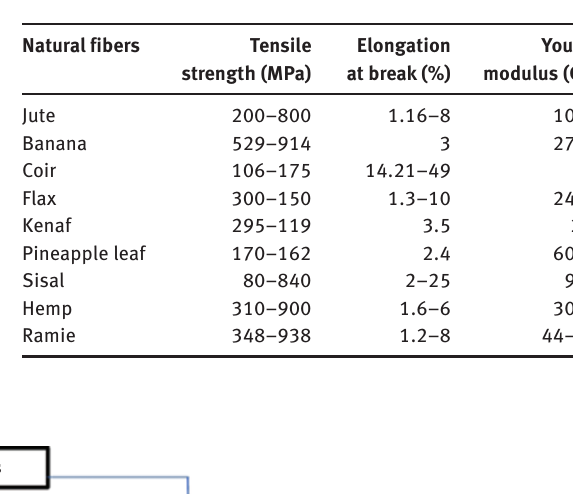
Table 3: Mechanical properties of different types of potential natural fibers for composite applications